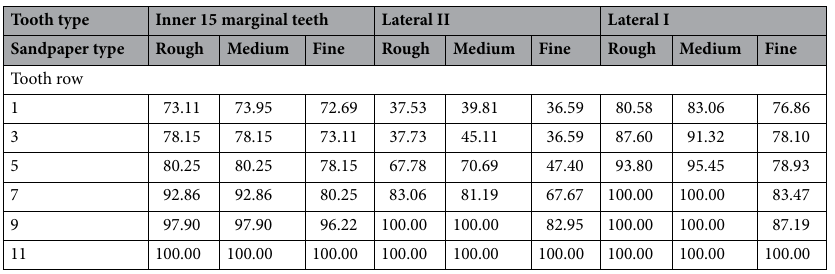
Table 3. Calculated tooth volume of the teeth (lateral I, lateral II, inner 15 marginal teeth) present in every second row (tooth row 1 = outermost row [oldest and most frequently used one]; tooth row 11 = first [youngest] row with slight signs of wear) after foraging on sandpaper (rough, medium, fine), in %, estimated by manipulating the 3D model until it looks similar to worn